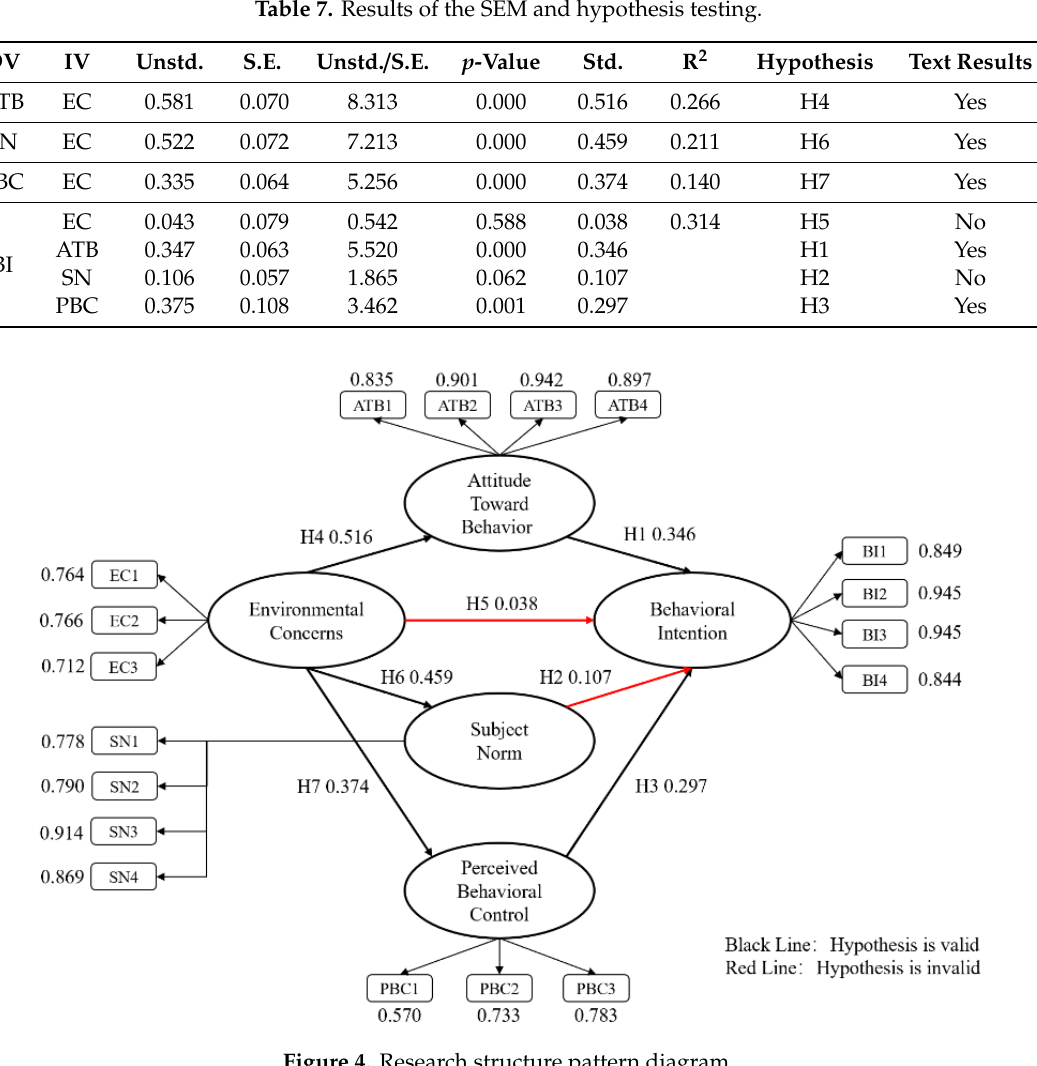
Figure 4. Research structure pattern diagram.